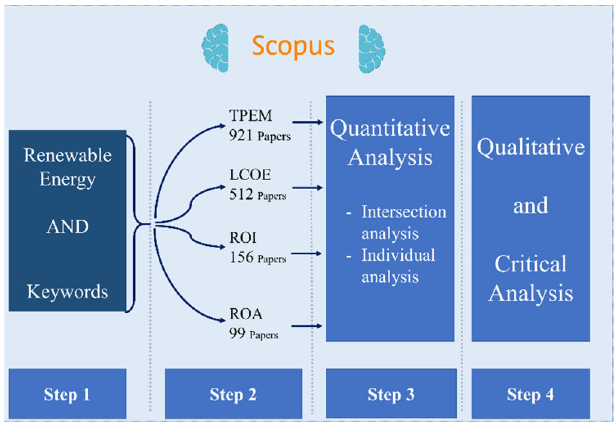
Figure 1. Operational procedures.